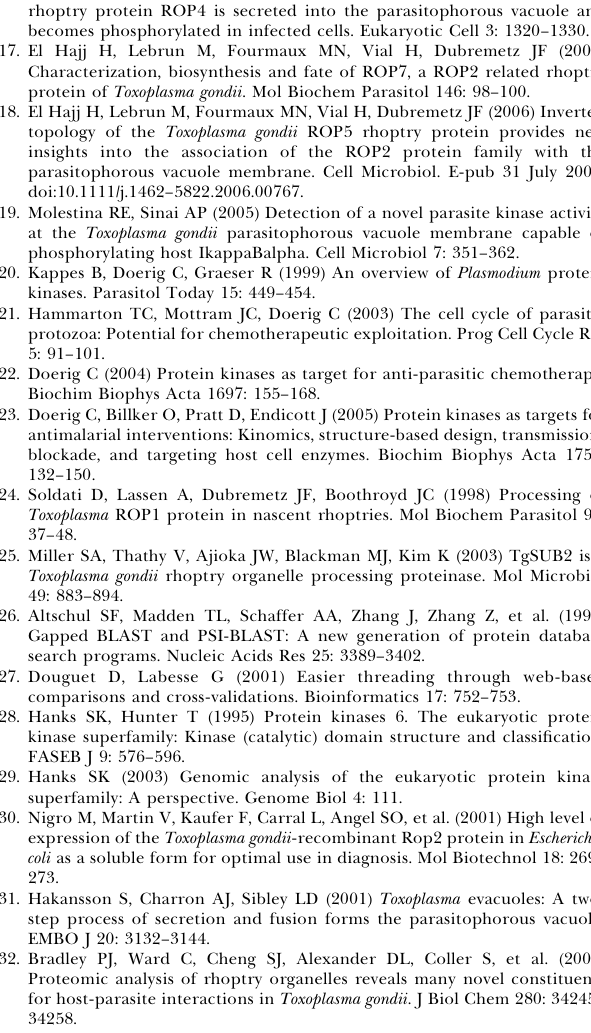
Figure S4. Fit of a Homology Model of ROP2 into the Ab Initio SAXS Envelope The cartoon presentation of the homology model (magenta) was fitted into the best GASBOR pseudo-residue reconstruction (green spheres) obtained from ten individual trails ( v 2 for best GASBOR model to data was 6.2). Left and right panels are perpendicular views. Figure S5. DLS Spectra of Recombinant ROP2 (Red) and Refolded Recombinant ROP18 (Green) Observed sizes are similar ( ; 70 A˚ ) and in agreement with those deduced from SAXS experiment performed on ROP2. Found at doi:10.1371/journal.ppat.0030014.sg005 (64 KB PPT). Figure S6. Intracellular Proliferation Rate at 16 h Post-Invasion by Wild-Type Tachyzoites (HX) and Tachyzoites Expressing an Addi- tional Copy of ROP18-Ty (ROP18Ty) or a D 394 A-Mutated Version Thereof (ROP18Ty MUT) Graph representation of the mean number of parasites per vacuole (HX versus ROP18Ty: 5 experiments; HX versus ROP18TyMUT: 3